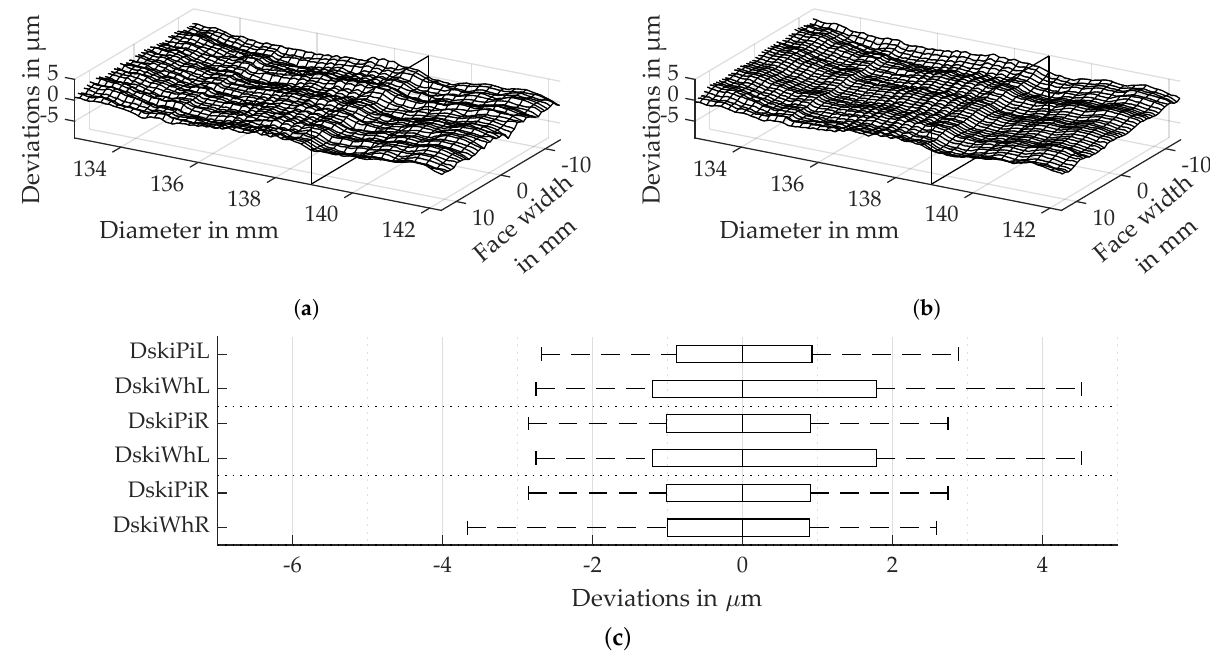
Figure 13. Deviations for gear skiving with half of the axial feed. ( a ) Flank of gear DskiPiL at tooth nr. 10. ( b ) Median of all teeth of gear DskiPiL. ( c ) Box plot of the deviations in the gear pairs.